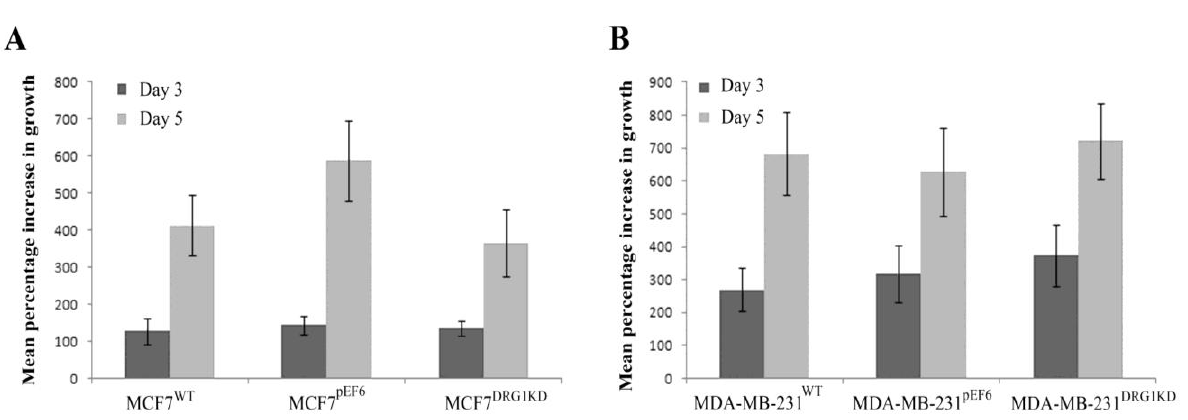
Figure 3. Effect of knockdown of DRG1 on MCF7 and MDA-MB-231 cell growth